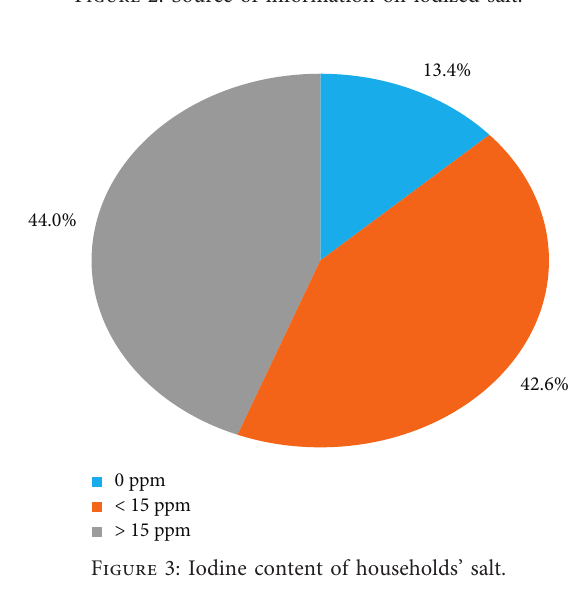
Figure 2: Source of information on iodized salt.